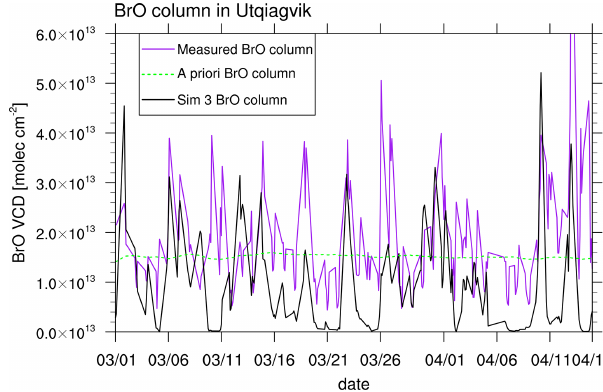
Figure 11. Comparison of modeled (simulation 3) BrO VCDs and measured BrO VCDs from MAX-DOAS at Utqia˙gvik (Frieß et al., 2011). The data are shown at 00:00GMT − 9 (LT at Utqia˙gvik). Also shown is an a priori BrO column for days with low